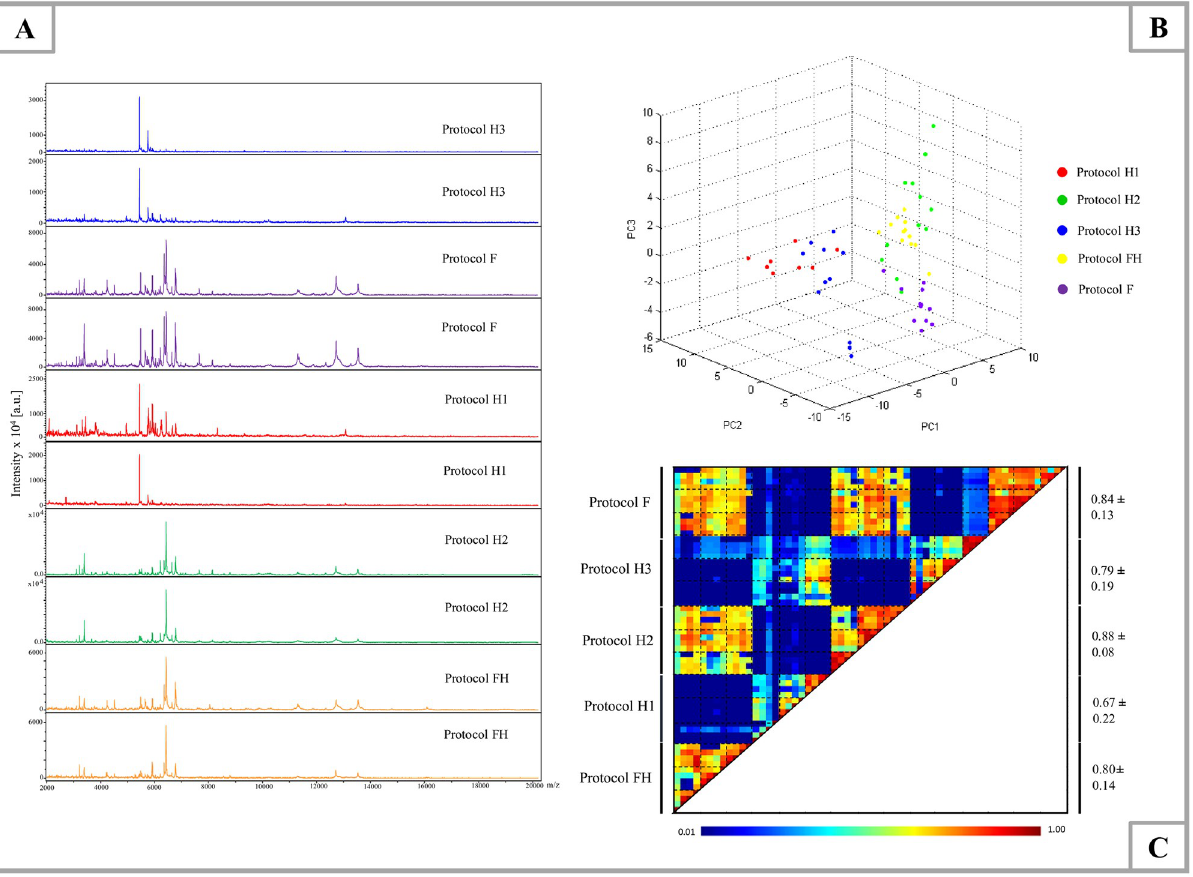
Fig 3. Comparison of MALDI-TOF MS spectra of Bi . pfeifferi using different protocols (H: head, FH: foot-head, F: foot). (A) Representative MS spectra from Bi . pfeifferi head (H1, H2, H3), foot-head (FH) and foot (F). (B) MALDI-TOF MS spectra distinction from Bi . pfeifferi between protocols compared by principal component analysis using ClinProTools v.2.2; protocol H1(40 μ l Mix+ tungsten beads), protocol H2 (40 μ l Mix+ glass beads), protocol H3 (30 μ l Mix+ glass beads), protocol FH (30 μ l Mix+ glass beads) and protocol F (30 μ l Mix+ glass beads). (C) Evaluation of MS spectra reproducibility generated by the five protocols using composite correlation index (CCI). The MS parameters: intensity � 3.000 [a.u.], absence of background noise and the reproducibility of MS spectra. a.u.: arbitrary units; m / z : mass-to-charge ratio. The protocol F was selected to build the MS reference database and perform the